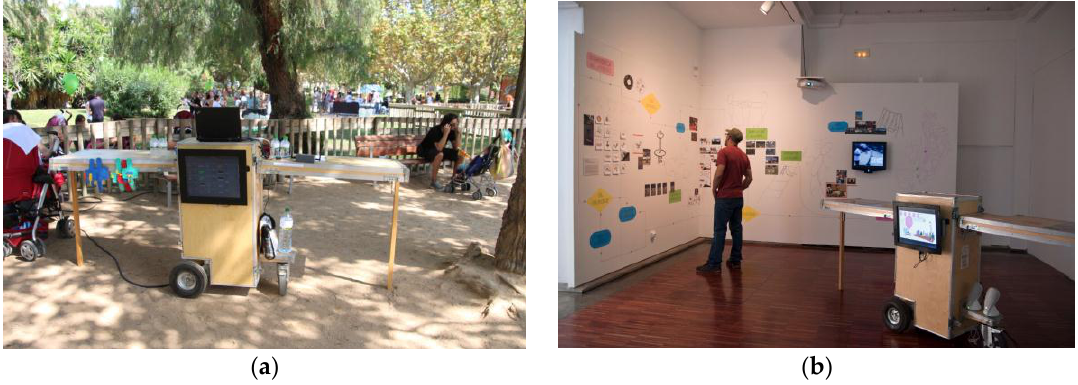
Figure 15. Cart of HybridPLAY in the park ( a ) with the monitor showing the score of the games and at one of the exhibitions ( b ) with the monitor showing a loop of the video games.